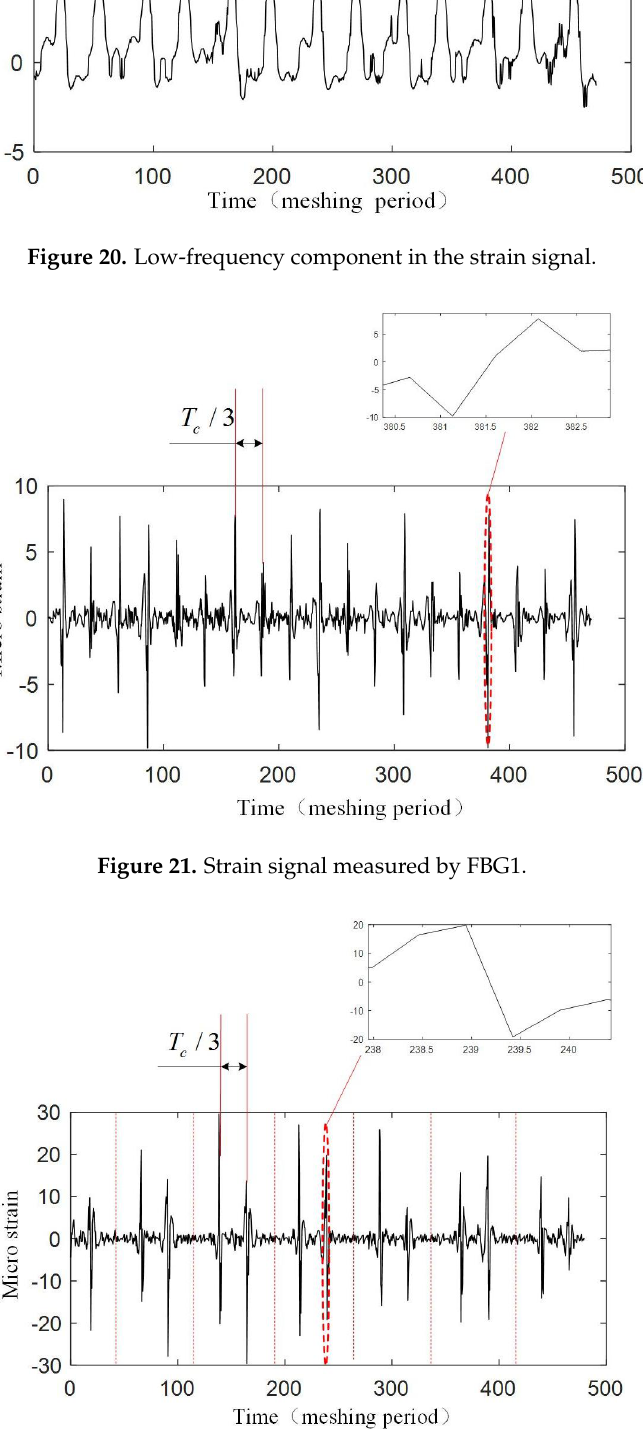
Figure 22. Strain signal measured by FBG2.